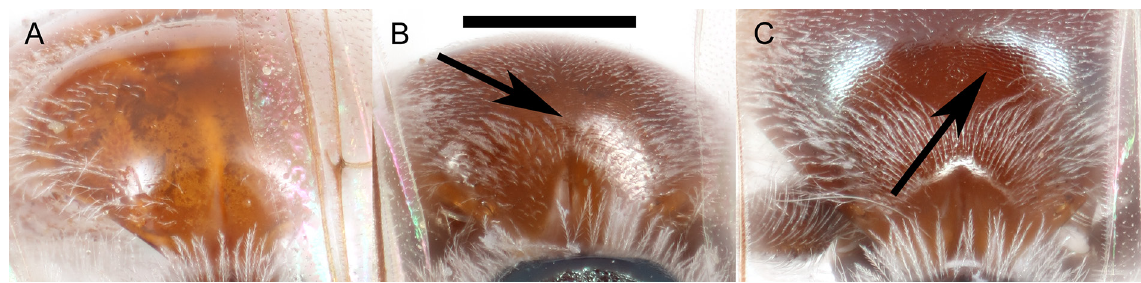
Fig. 95. T1 anterior face. A . Lasioglossum ( D. ) kunzei (Cockerell, 1898), ♀, shiny with weak and worn acarinarial fan. B . L. ( D. ) argammon sp. nov., ♀, weakly coriarious with sparse acarinarial fan. C . L. ( D. ) rufornatum sp. nov., ♀, strongly coriarious with dense and well-developed acarinarial fan. Arrows point to areas where microsculpture is most easily visible. Scale bar is 0.5 mm.